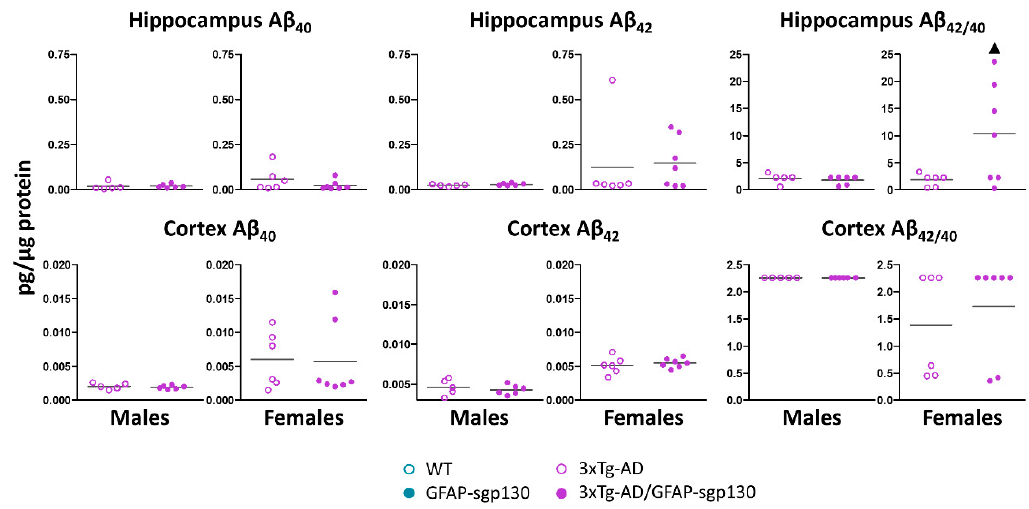
Figure 6. Presence of A β in brain of 3xTg-AD mice. Low levels of A β were detected in cortex and hippocampus from 3xTg-AD mice fed with HFD. The inhibition of the IL-6 trans-signaling significantly increased the ratio A β 42 / A β 40 in the hippocampus. Results are MEAN ± SEM. ▲ p ≤ 0.05 vs. sgp130Fc negative.